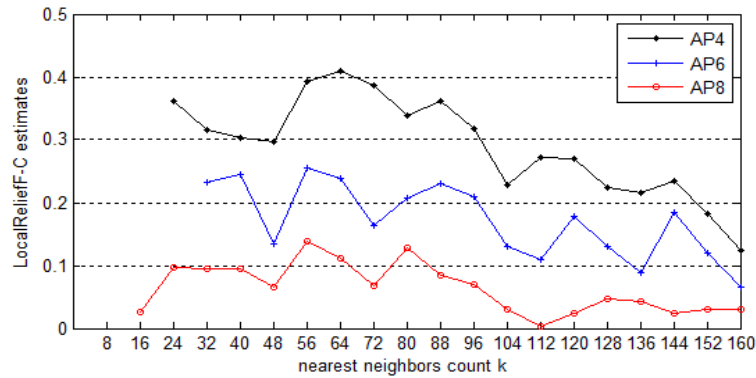
Figure 8. Estimated weights change with iteration m at reference Location 12.